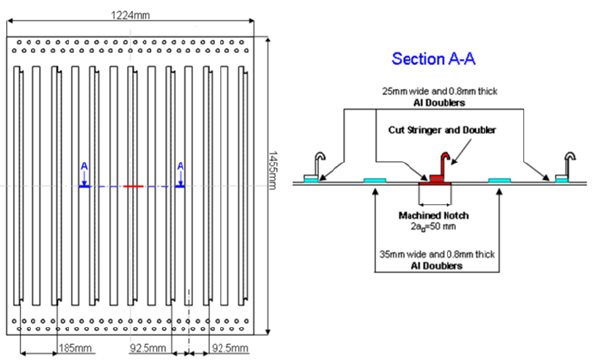
Figure 4: Representation of a “seven stringers” panel with doublers bonded between and under the stringers (a) and with an additional glass fiber reinforcement